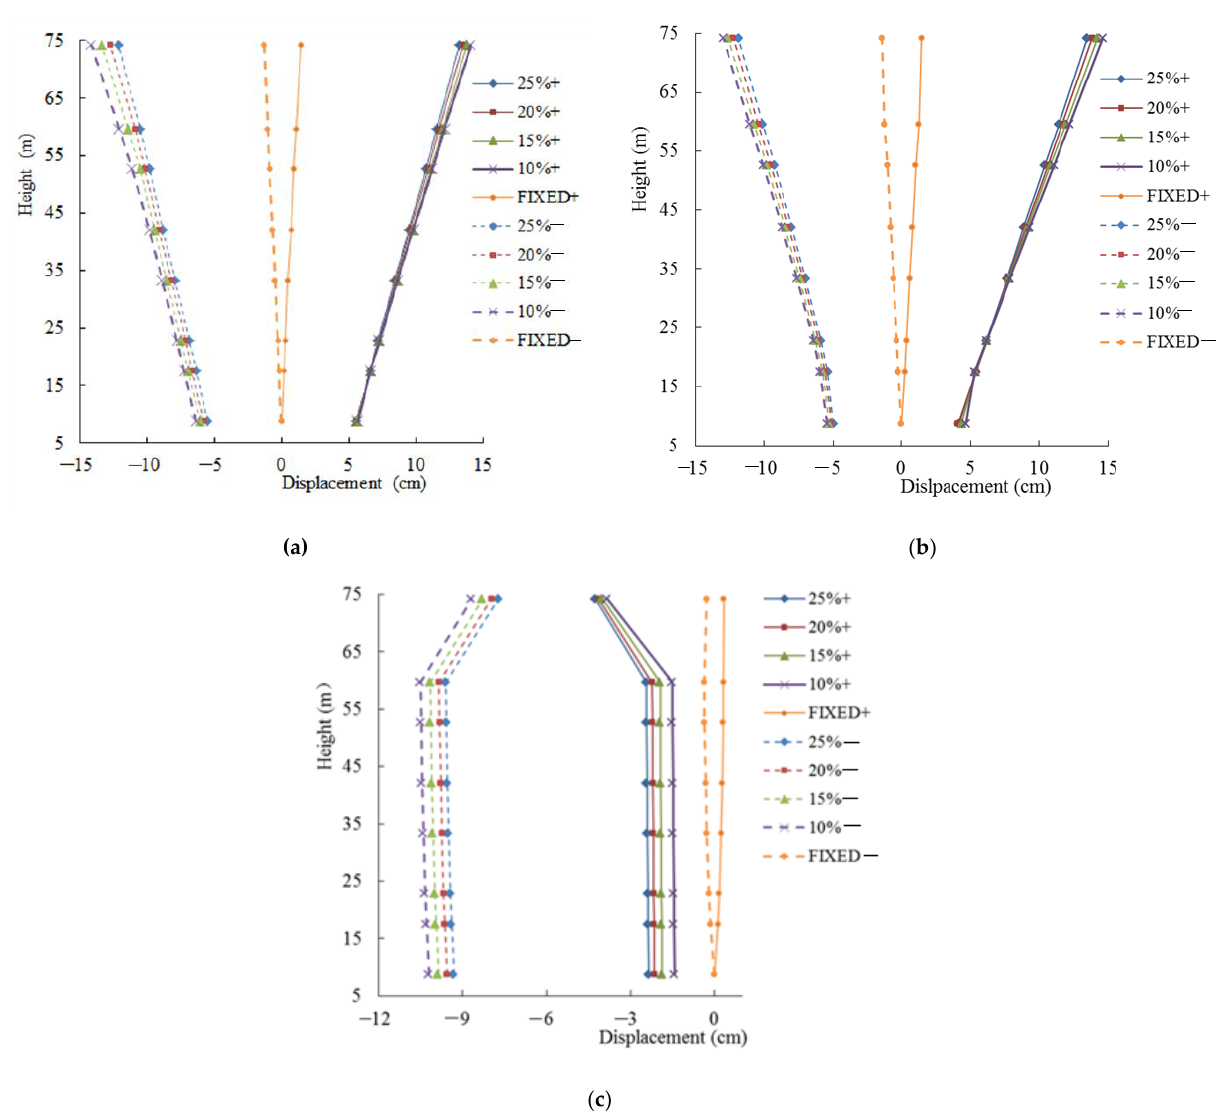
Figure 13. Comparison of the peak displacement response of the containment. ( a ) In the horizontal direction X ; ( b ) In the horizontal direction Y ; ( c ) In the vertical direction Z .